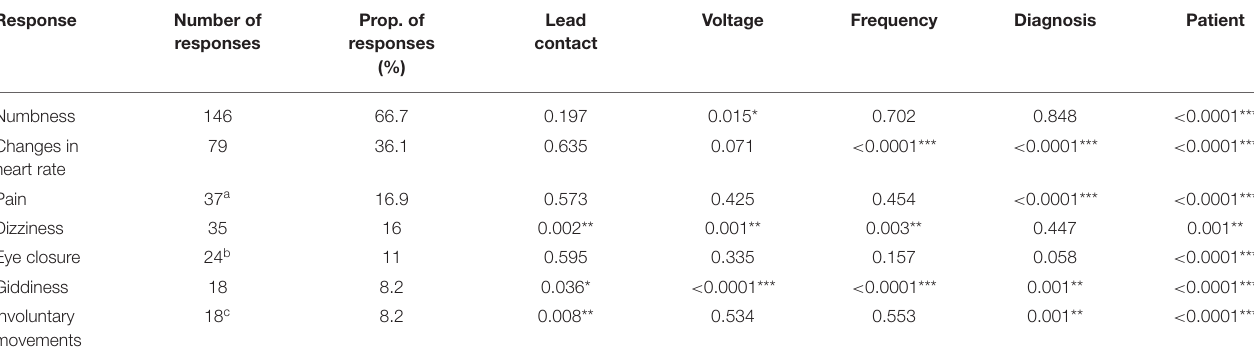
TABLE 2 | Relationships of trial conditions with responses.